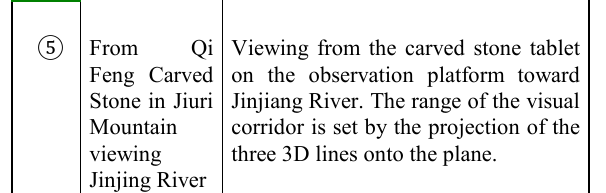
Table 1. Description of the Range of Visual Corridors